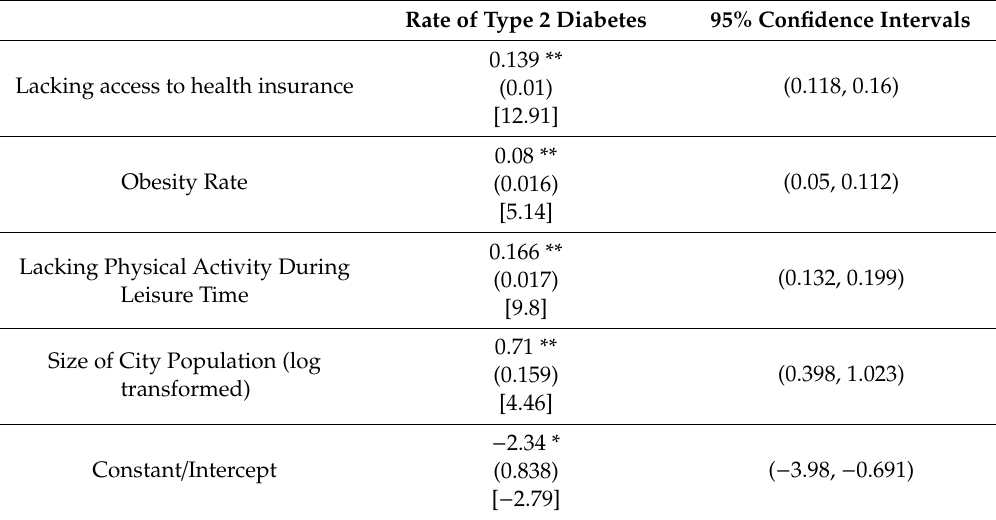
Table 2. E ff ects of insurance access, obesity, sedentary behavior (during leisure time) and size of city population on the rate of type 2